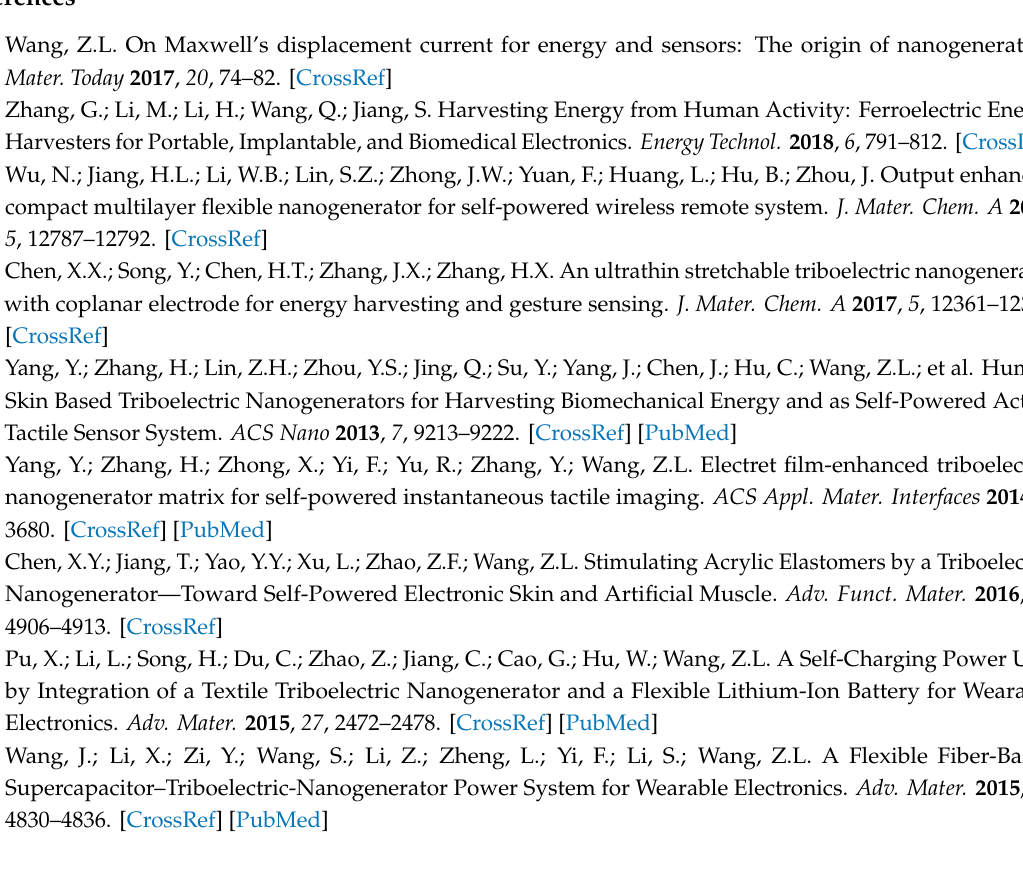
Figure S1: 0.8 Hz frequency change voltage output, Figure S2: Output current and output power of NG with various external load resistances, Figure S3: NG’s sensing size for di ff erent weights, Video S1: Temperature-humidity sensor driven by NG, Video S2: Electric watch driven by NG, Video S3: The device fixed to an